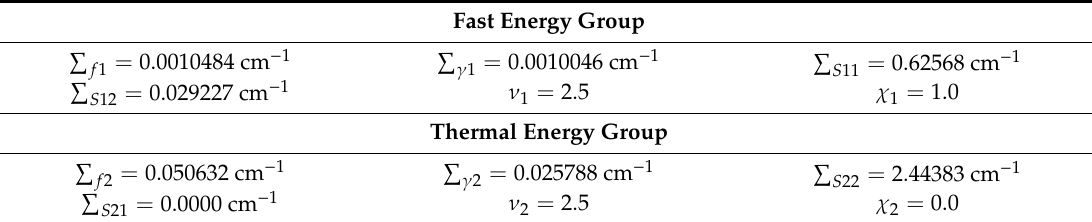
Table 1. Two Group Data.